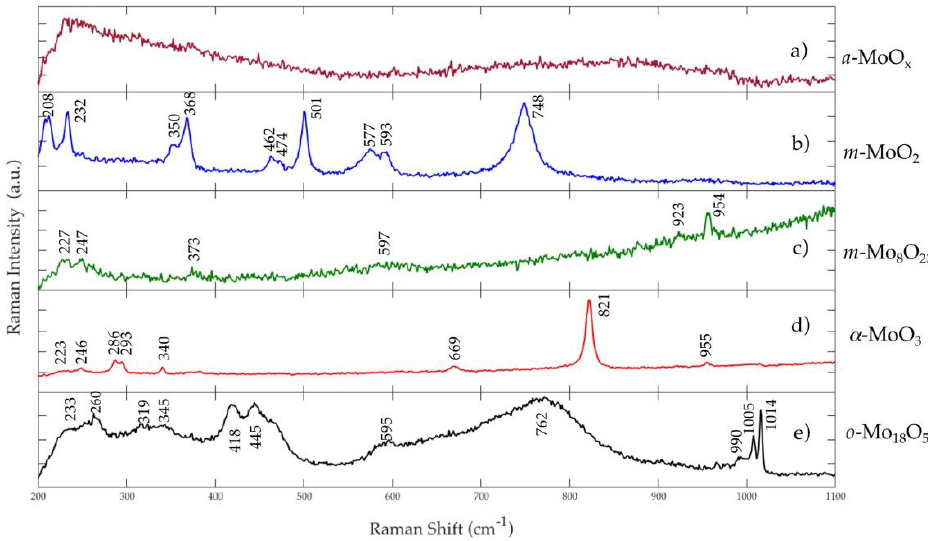
Figure 3. Representative Raman spectra for the center at each irradiated spot within the five background colored frame blocks (dark-red, blue, green, light-red, black) in Figure 2. ( a ) a -MoO x (amorphous molybdenum oxide); ( b ) m -MoO 2 ; ( c ) m -Mo 8 O 23 ; ( d ) α -MoO 3 ; ( e ) o -Mo 18 O 52 .